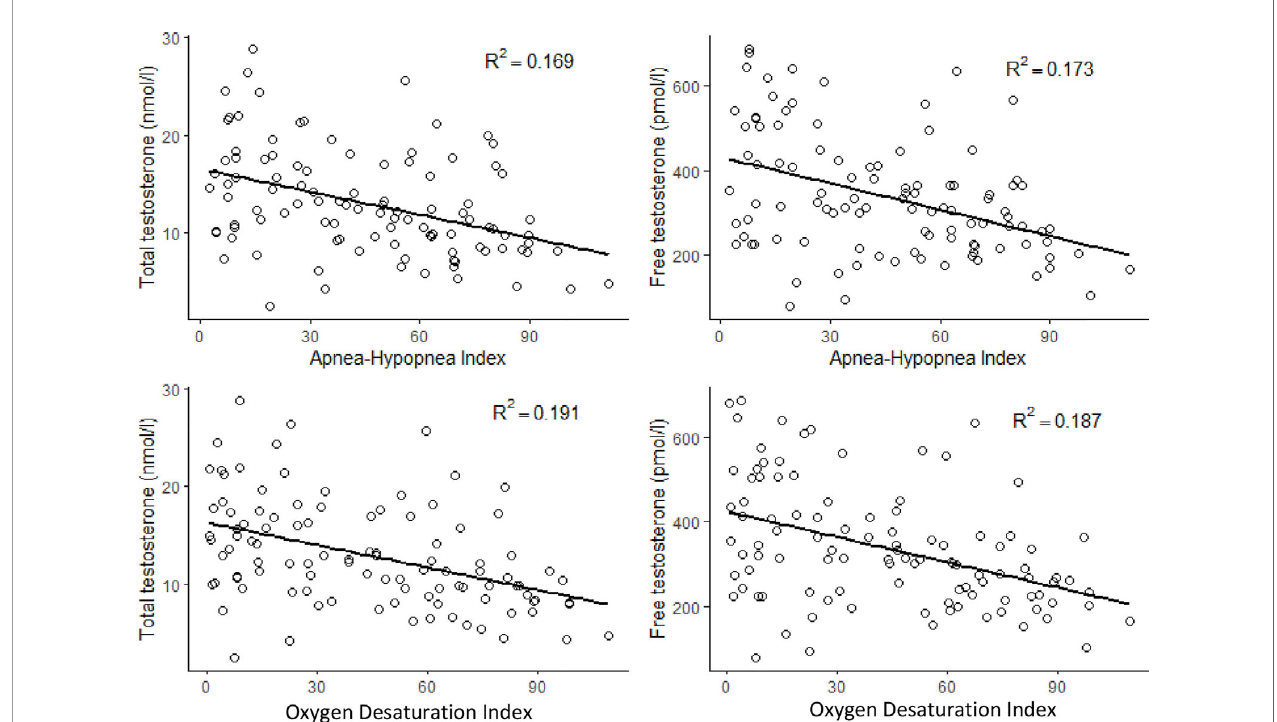
FIGURE 2 | Correlations between total testosterone and free testosterone with apnea-hypopnea index and oxygen desaturation index.